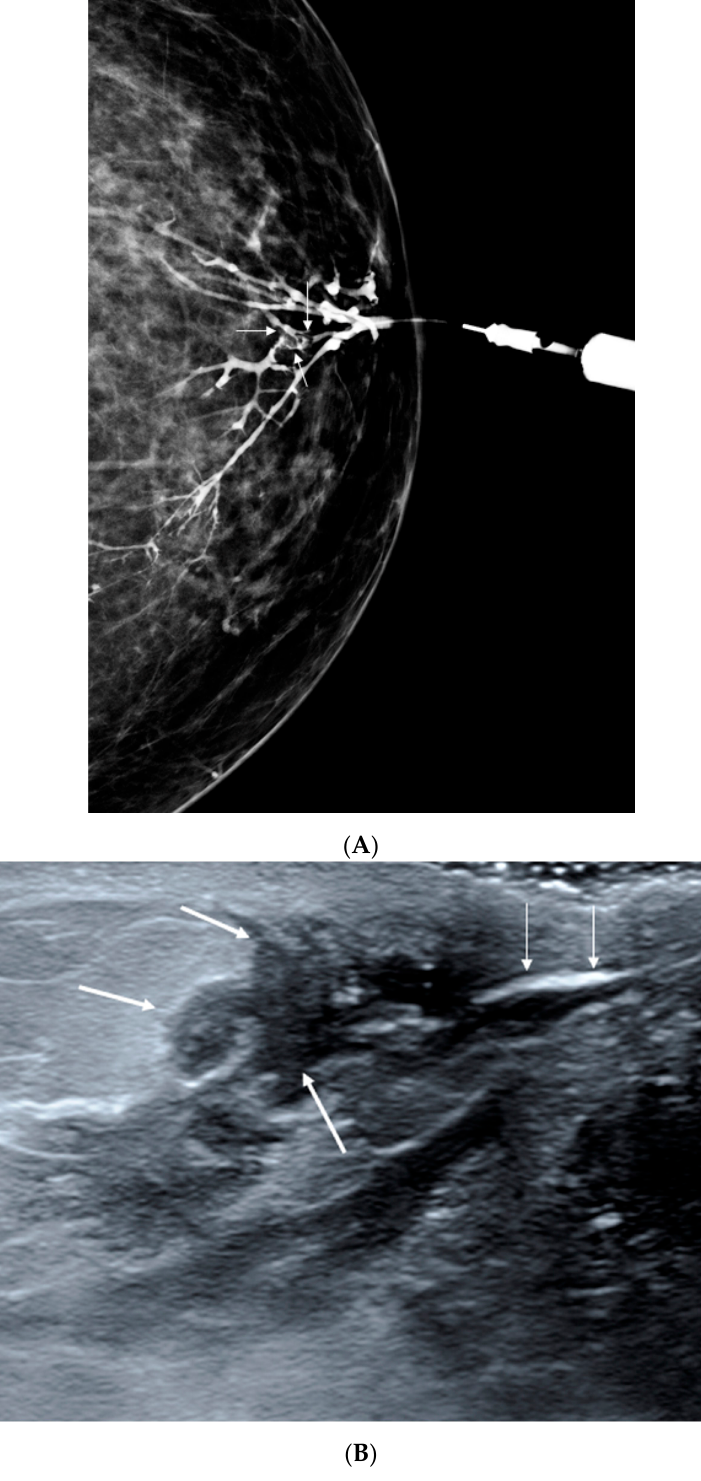
Figure 5. A 58-year-old woman with a pathological diagnosis of ductal carcinoma in situ. ( A ) Mag- nified galactogram which shows microdefects with a moth-eaten appearance (arrows), which was included in the GICS 5 category: high suspicion of malignance. ( B ) Sonogram showing a solid hyper- echoic pattern with badly-defined duct wall (thick arrows), and intraductal hyperechoic content (thin arrows), which correspond to the contrast dye